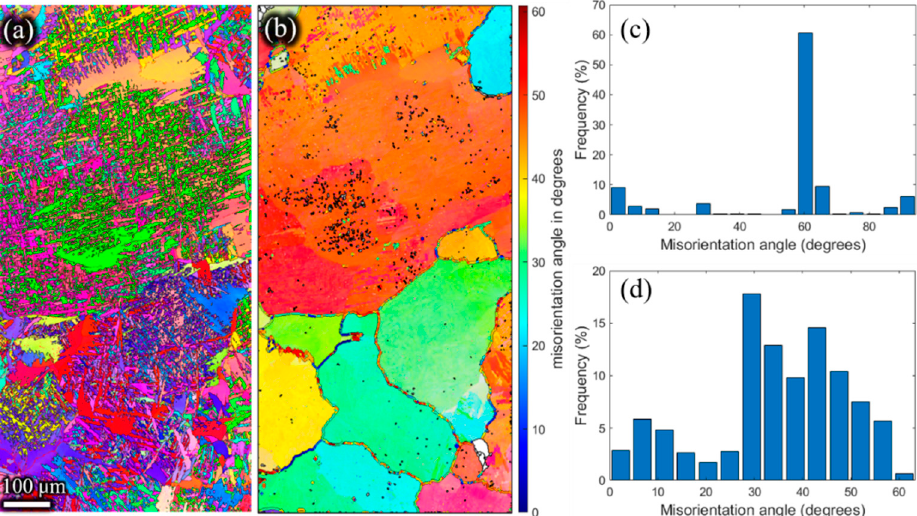
Figure 14. Inverse pole Figures of ( a ) the α phase, and ( b ) the reconstructed β phase. Misorientation angle of ( c ) α grains, and ( d ) reconstructed β grains of the residual deformed billet with a holding time of 180 s.